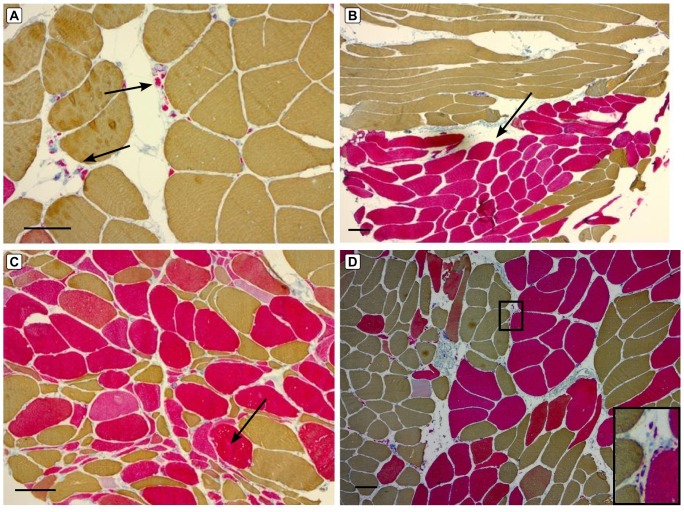
Neurogenic muscle biopsy findings in SMAJ, SBMA and c9ALS.Small groups of rounded type IIA fibers (arrows) in a vastus lateralis muscle biopsy of a 48-year-old male with SMAJ (A). Extensive fiber type grouping involving non-atrophic type IIA fibers (arrows) shown in a tibialis anterior biopsy of a 55-year-old SMAJ female patient (B). Groups of angulated atrophic fibers with mixed fiber types (arrows) in a vastus lateralis muscle of a 52-year-old female patient with c9ALS (C). Small groups of extremely atrophic type IIA fibers (inset) in a tibialis anterior biopsy of a 60-year-old male patient with SBMA (D). Figs A-D: myosin heavy chain double stain immunohistochemistry showing type IIA fibers in red, IIX fibers in blue and type I fibers in brown color. Scale bar = 100 micrometers